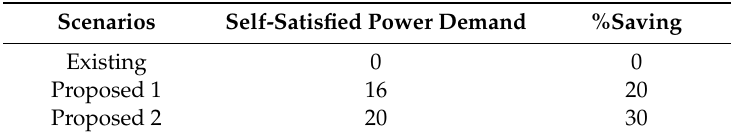
Table 7. Comparison of self- satisfied power demand between existing and proposed scenarios over 48 h time period.